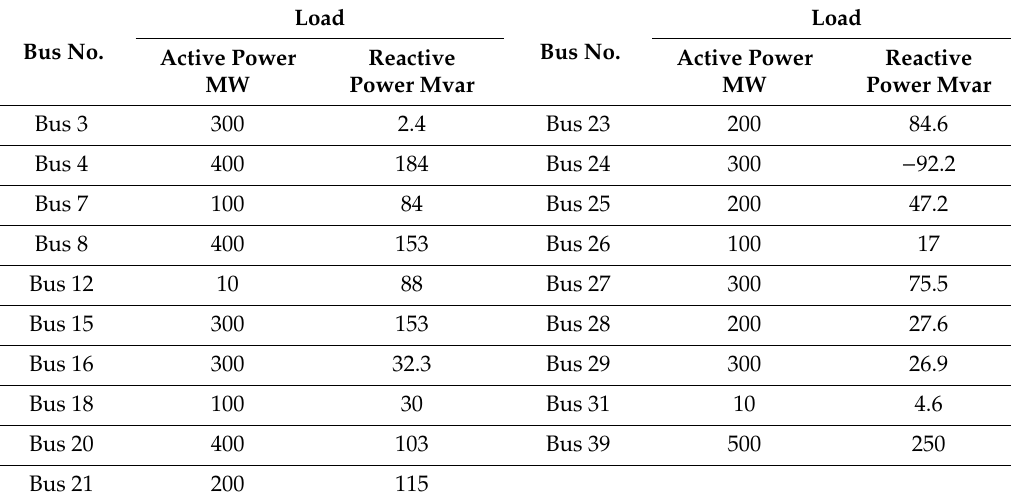
Table A1. Load data of modified IEEE RTS